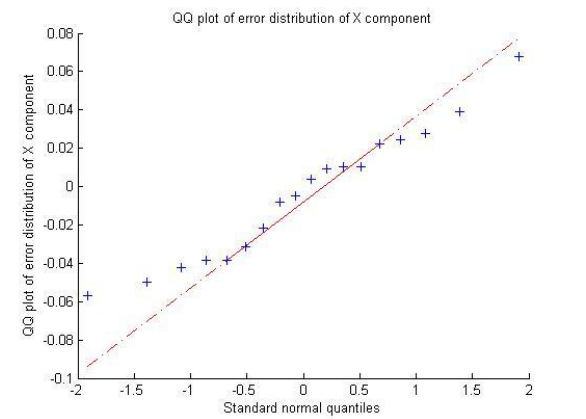
Figure 8. Q-Q plot for the distribution of ΔX